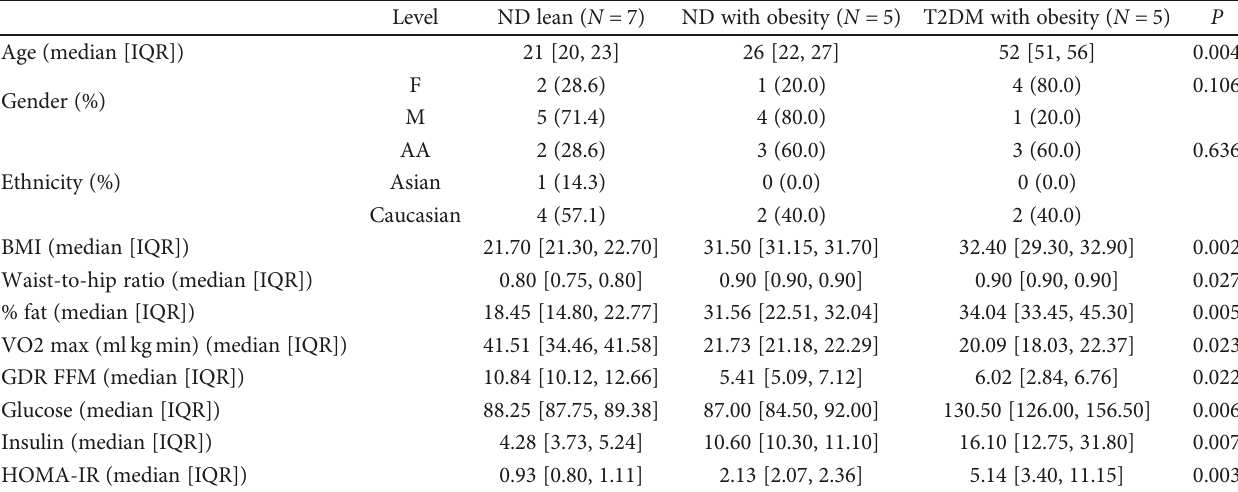
Table 1: Demographic and clinical characteristics of the study